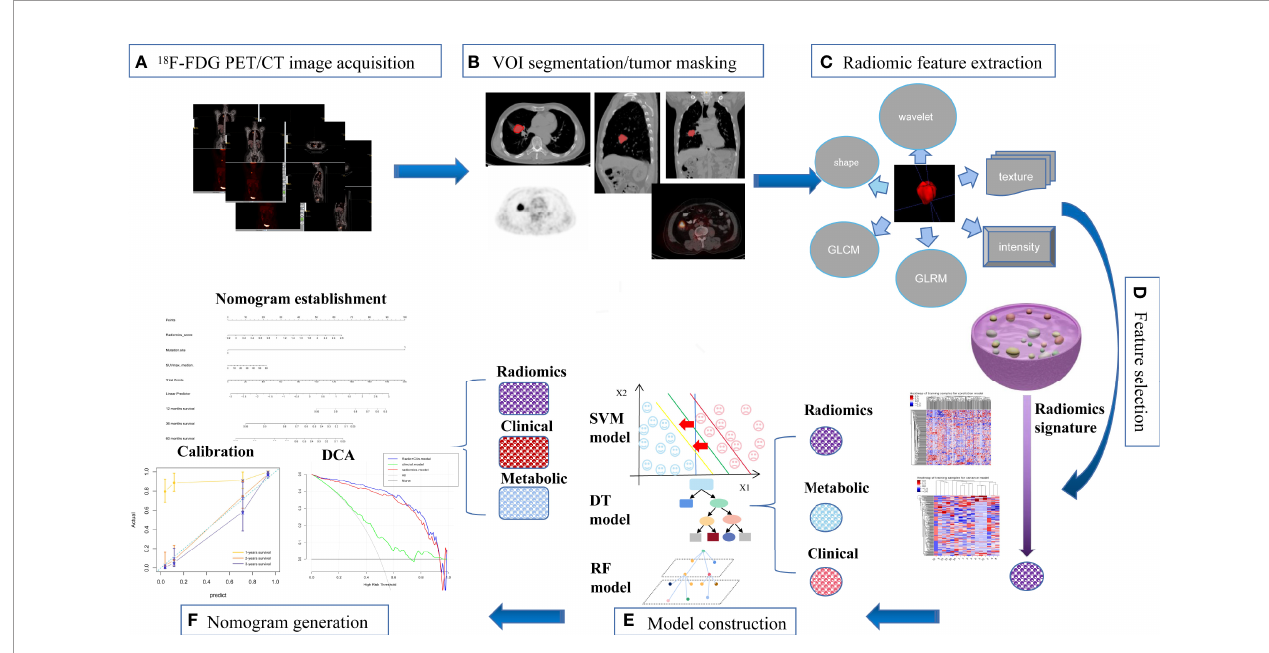
FIGURE 2 | The work fl ow of our study. (A) image acquisition; (B) tumor masking; (C) feature extraction; (D) feature selection; (E) model construction; (F) nomogram